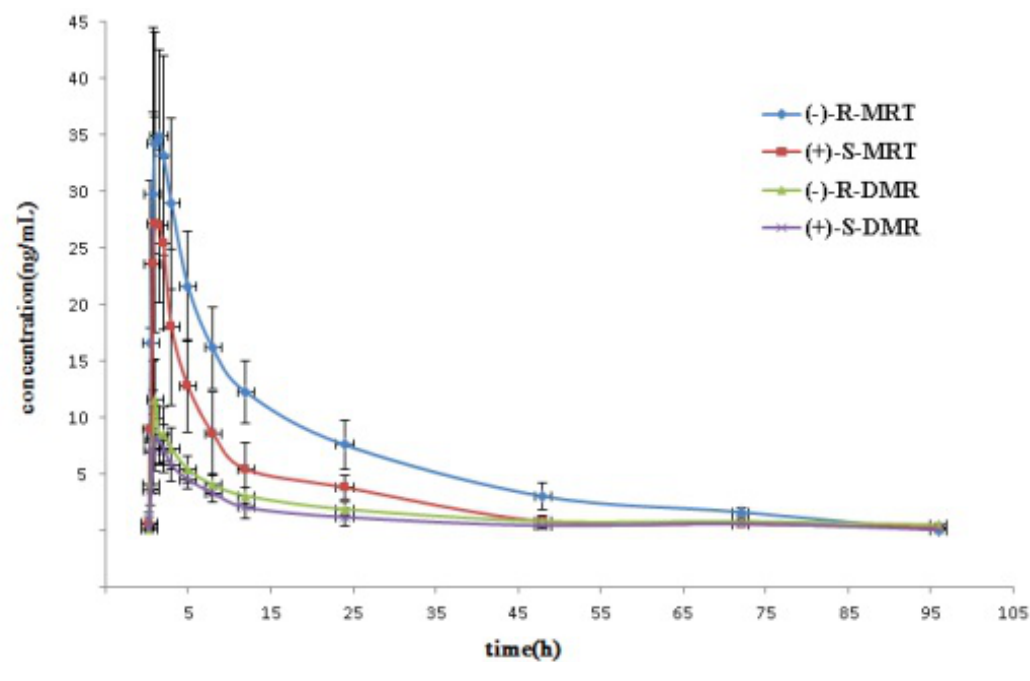
Figure 6. Mean plasma concentration–time profiles for MRT and DMR enantiomers in 12 healthy male volunteers following oral administration of rac -MRT 30 mg.